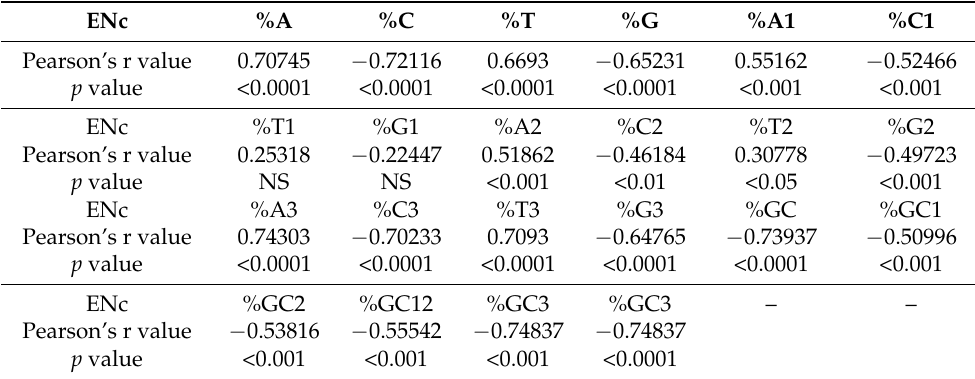
Table 3. Effect of nucleotides in agreement to their position in codon on